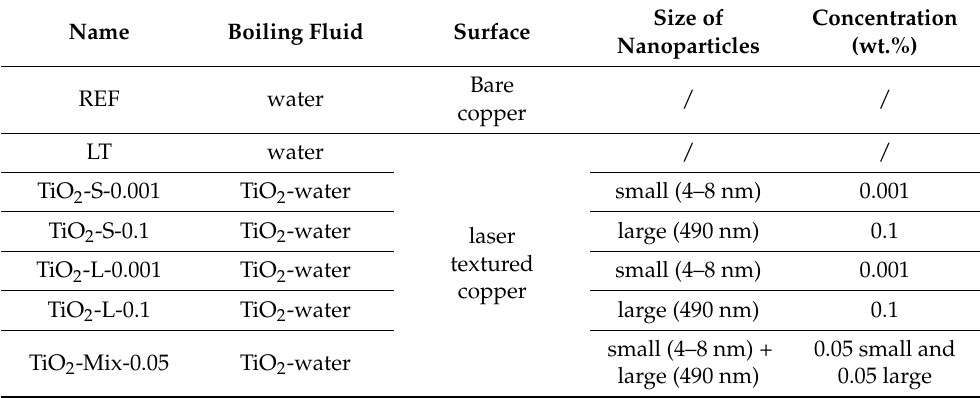
Table 1. The characteristics of the performed